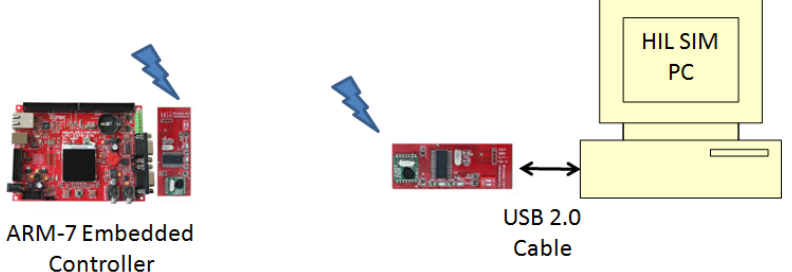
Figure 4. Prototype test